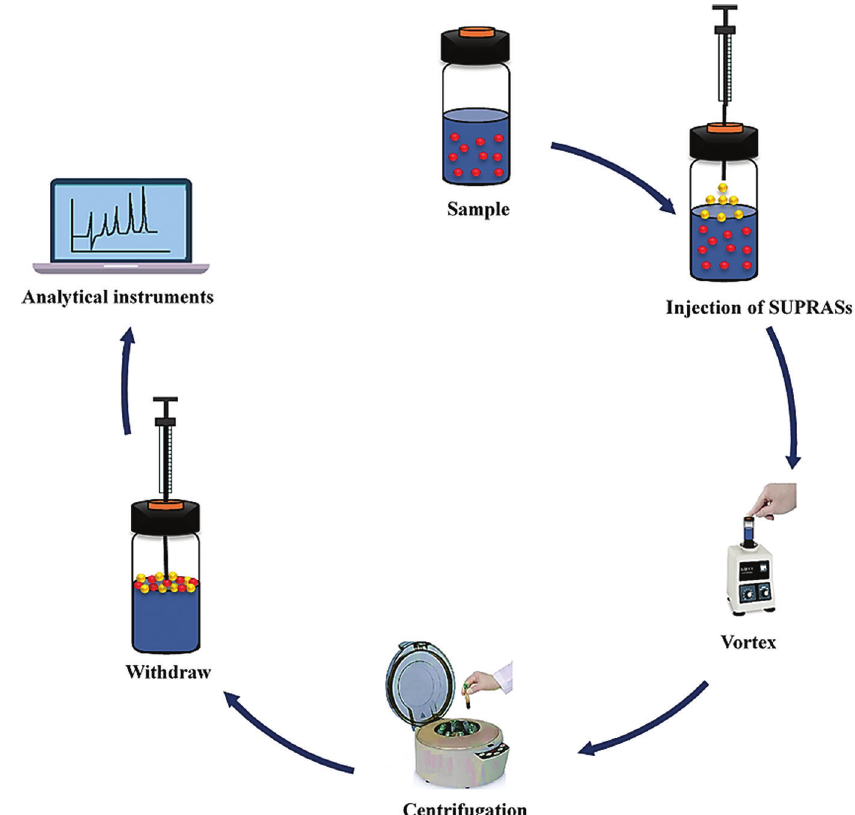
Figure 3: Schematic presentation of SSME